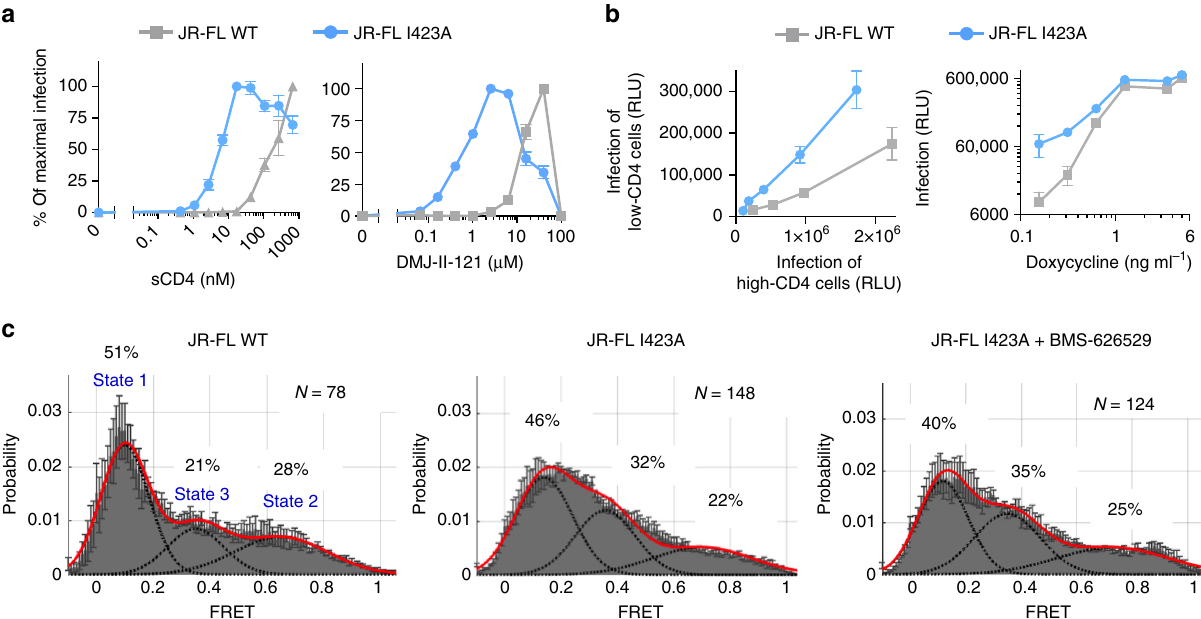
Fig. 5 The effect of the I423A change on CD4 dependence and Env conformation. a Recombinant viruses carrying the wild-type (WT) or I423A HIV-1 JR- FL Env were incubated with CD4-negative, CCR5-expressing Cf2Th cells in the presence of the CD4-mimetic compound DMJ-II-121 or sCD4 at the indicated concentrations. The percentage of maximal infection for each virus variant is reported here. The maximal infection levels after DMJ-II-121 addition were 297,656 and 70,626 relative luciferase units for viruses with the WT and I423A Envs, respectively. Error bars represent s.e.m. b Infection of cells with different levels of CD4. Left, parallel titration of wild-type (WT) or I423A HIV-1 JR-FL on af fi no fi le cells that were induced to express low or high levels of CD4. Right, the effect of different levels of CD4 expression, induced by doxycycline treatment of af fi no fi le cells, on the infectivity of WT or I423A HIV-1 JR- FL . Maximal infection levels were 675,978 and 613,708 relative luciferase units for viruses with the WT and I423A Envs, respectively. c Single-molecule fl uorescence resonance energy transfer (smFRET) probes were placed in the gp120 V1 and V4 loops of WT or I423A HIV-1 JR-FL Envs. The FRET trajectories were compiled into population FRET histograms and fi t to the Gaussian distributions associated with each conformational state, according to a hidden Markov model 18 . The percentage of the population that occupies each state as well as the number of molecules analyzed is shown and represents